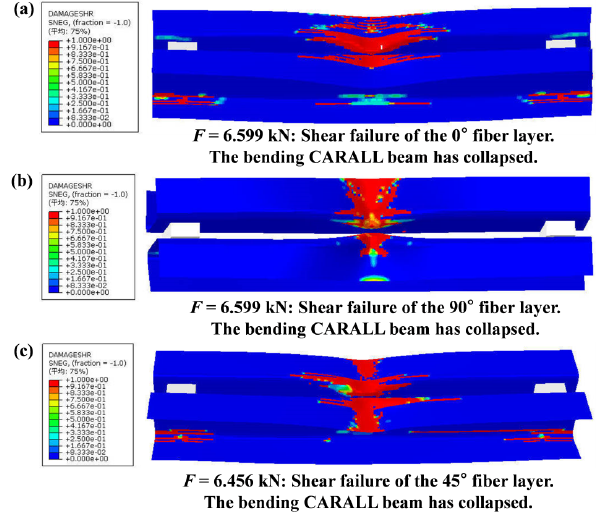
Figure 25: Shear failure area distribution of fiber layers in final failure state: (a) SHCXL-A: 0 ∘ fiber layer; (b) SHCXL-A: 90 ∘ fiber layer; and (c) SHCXL-B: 45 ∘ fiber